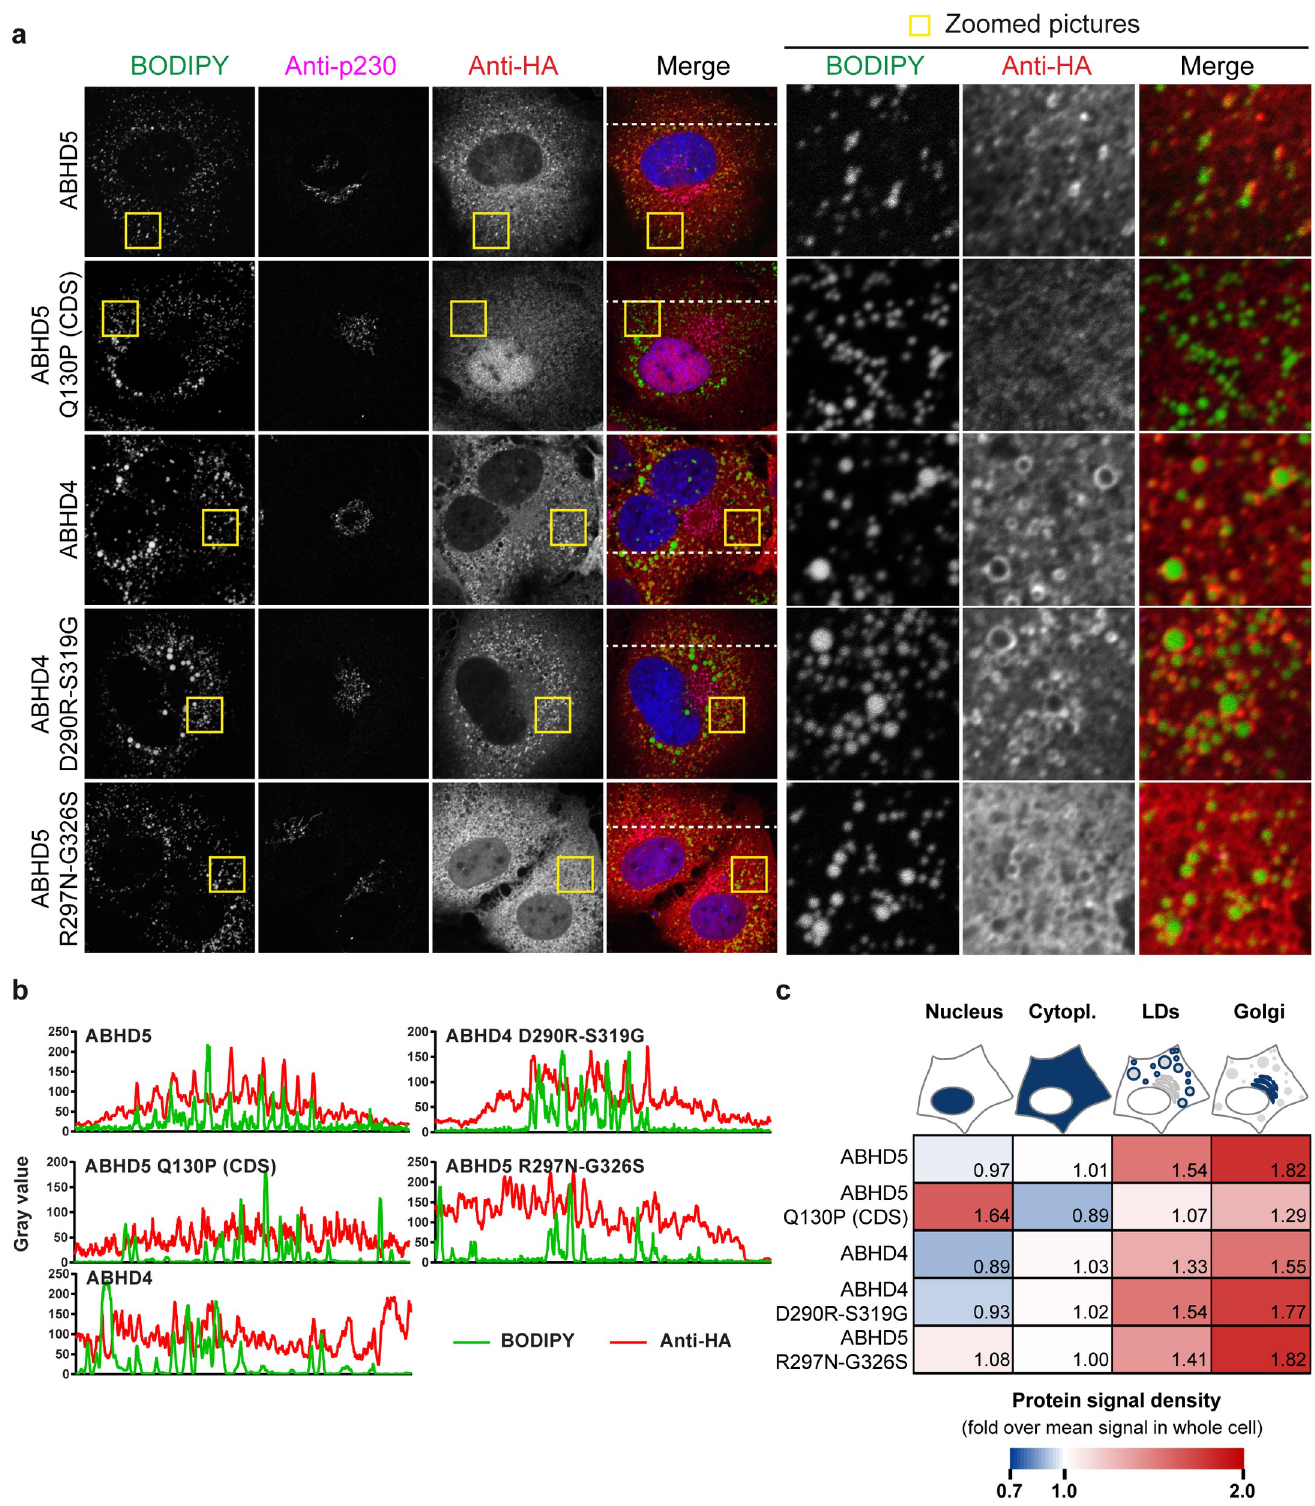
Fig 12. Subcellular localization of the ABHD4/5 mutants. ( a ) Immunofluorescence analysis of HA-tagged ABHD4/5 localization respectively to the lipid droplets (BODIPY 493/503) and trans -Golgi (p230 marker) in transduced Lunet N hCD81 cells. ( b ) Intensity profiles of the green and red channels along the line depicted in the merge pictures of panel a. ( c ) Quantification of ABHD4/5 accumulation in the nucleus, the cytoplasm, the Golgi apparatus and at the lipid droplet periphery. The